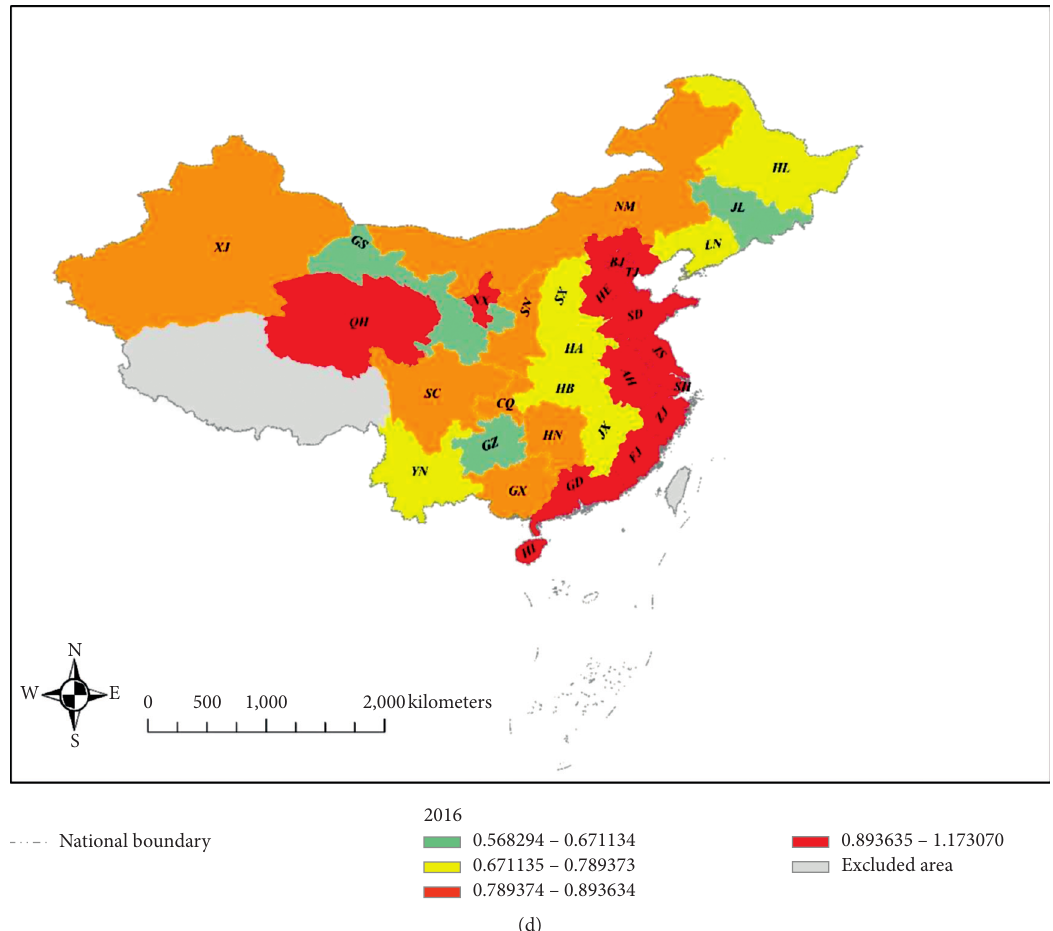
Figure 2: Urban construction land utilization efficiency of provinces in different